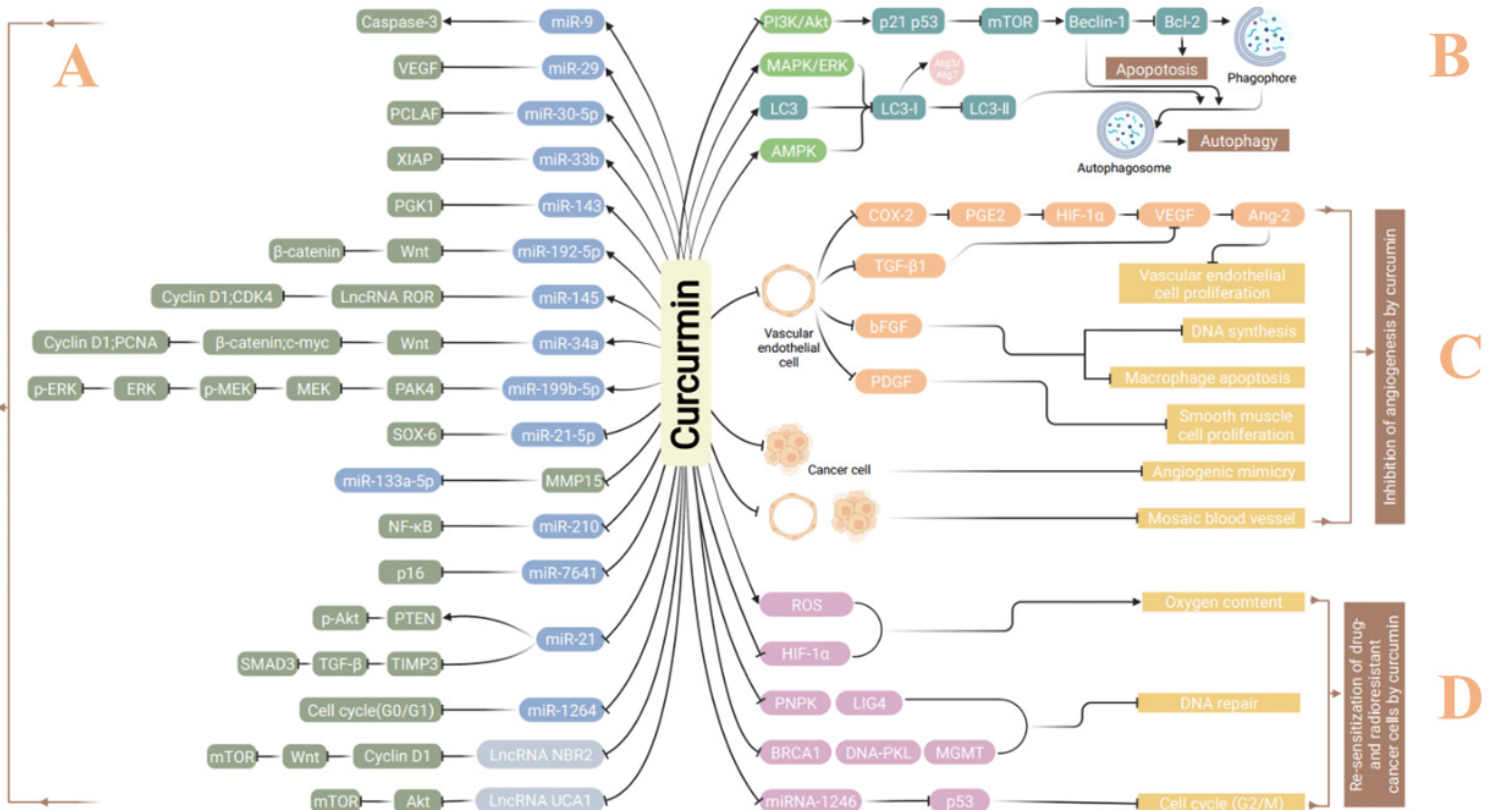
Figure 2. Part A: Curcumin inhibits proliferation and induces apoptosis of cancer cells through miRNA and lncRNA-mediated mechanisms. Part B: Curcumin- mediated autophagy of cancer cells. Curcumin may inhibit the PI3K/Akt signaling pathway to activate the autophagy marker Beclin-1, which induces apoptosis via inhibition of Bcl-2 and promotes the formation of autophagosomes from the free phagophores, inducing autophagy. Curcumin can also activate the MAPK/ERK and AMPK signaling pathways or LC3 to induce autophagy via an LC3-II-mediated mechanism. Part C: Inhibition of angiogenesis by curcumin. Curcumin can inhibit the proliferation of vascular endothelial cells and smooth muscle cells through COX-2/PGE2, TGF- β 1-, bFGF- and PDGF-mediated mechanisms. Curcumin can also inhibit the angiogenic mimicry of cancer cells and mosaic blood vessel formation in co-cultures of cancer cells and vascular endothelial cells. Part D: Re-sensitization of radioresistant cancer cells by curcumin. Curcumin can increase oxygen content through upregulation of ROS or downregulation of HIF-1 α , inhibit DNA repair and promote cancer cell arrest at G2/M through the miRNA-1246-mediated p53 pathway.